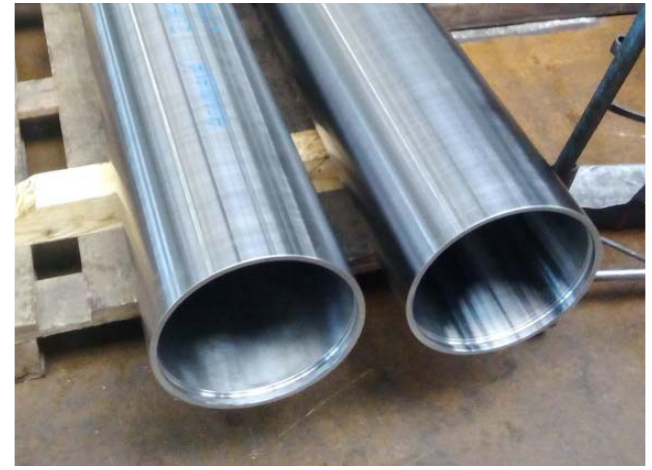
Figure 3. Workpiece steel cylinders before the application of bronze cladding.